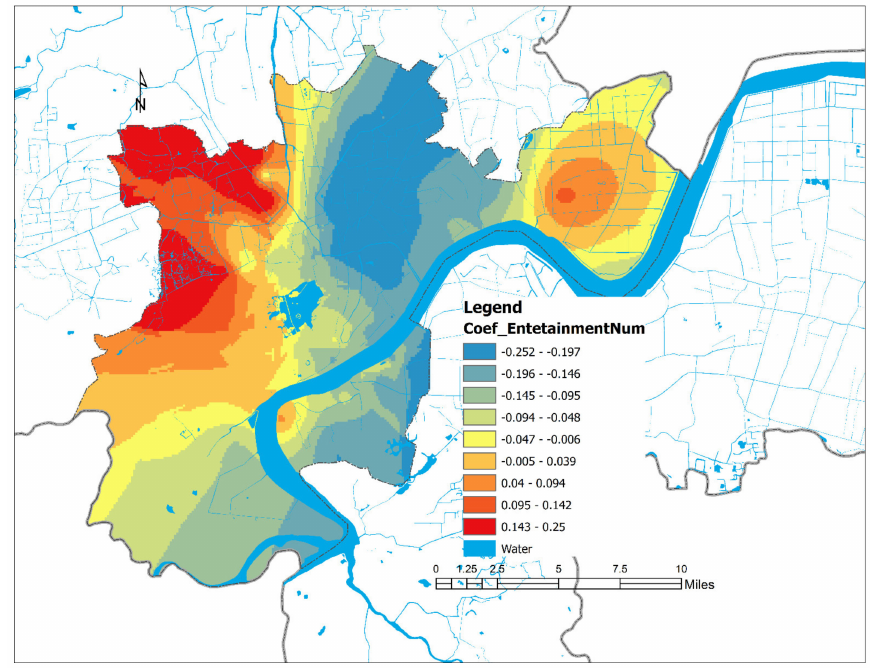
Figure 11. Life service facility maturity factor coefficient diagram of commercial land category